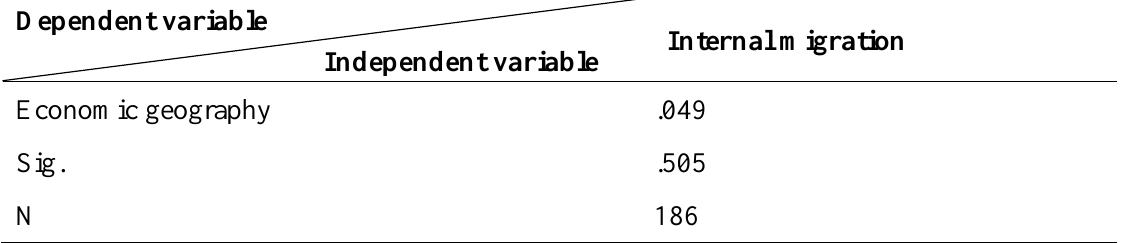
Table 6. Analysis of the correlation coefficient between the research variables